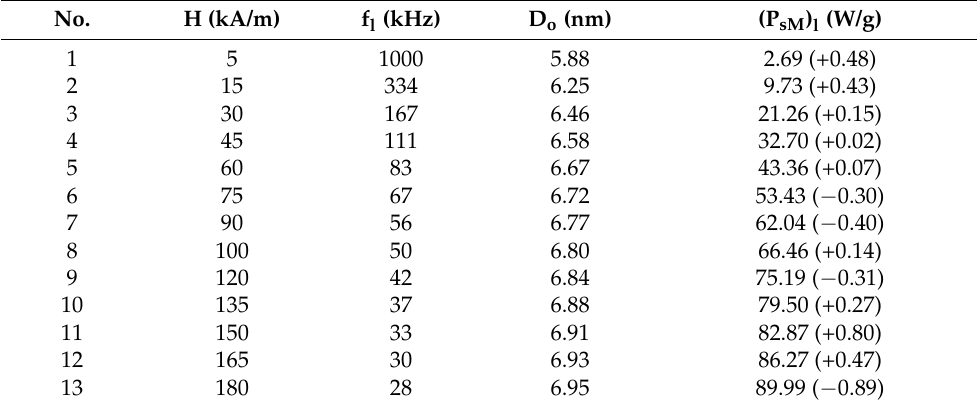
Table 3. The values of maximum specific loss power (P sM ) l for the optimal diameter (D o ) of CoFe 2 O 4 nanoparticles at the admissible biological limit for the parameters of magnetic field H and f l (the limit frequency) resulting from the condition given by Equation (13).